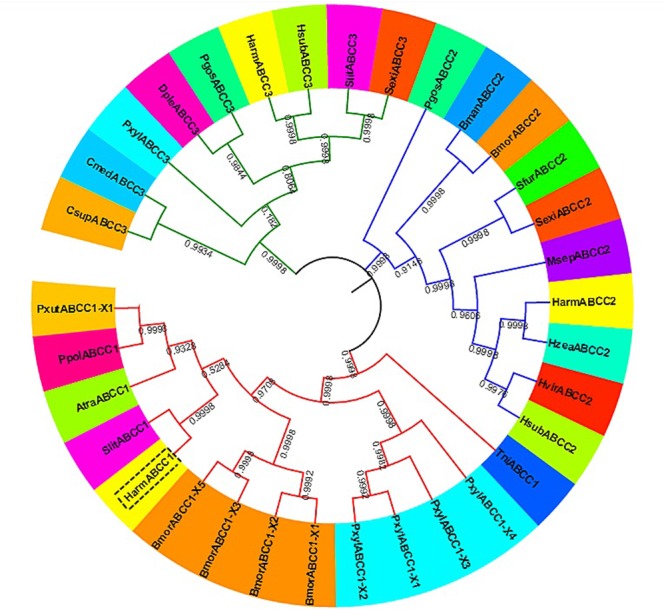
An unrooted phylogenetic tree showing the phylogenetic relationships of ABCC1–3 genes from different insect species. The tree was generated by a ClustalW alignment of the full-length amino acid sequences of ABCC1–3 using the neighbor-joining method in MEGA 7.0. Bootstrap values are expressed as percentages of 1,000 replications. GenBank accession numbers or Gene IDs are displayed in parentheses in Supplementary Table S2.